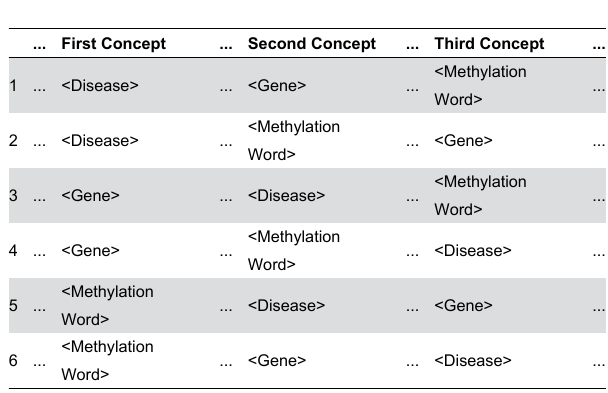
Table 1. Illustration of pattern